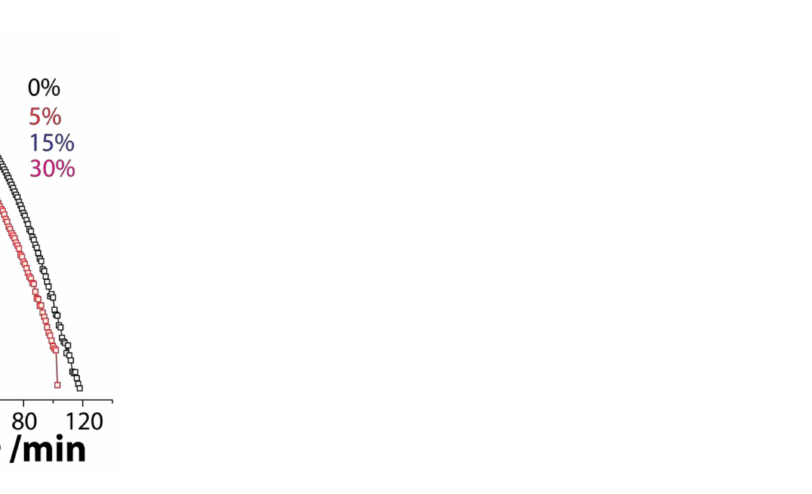
Figure 5. Redox catalysis using CuTCNQ catalyst. Time-dependent catalytic activity of CuTCNQ catalyst fabricated in 0%, 5%, 15%, and 30% v / v water, plotted as ln ( A t / A 0 ) versus the reaction time, where A t and A 0 are absorbance values of ferricyanide at time = t and at 0, respectively. Table 1. Catalytic performance of CuTCNQ catalyst grown in water–DMSO bisolvent (30% v/v water) under different